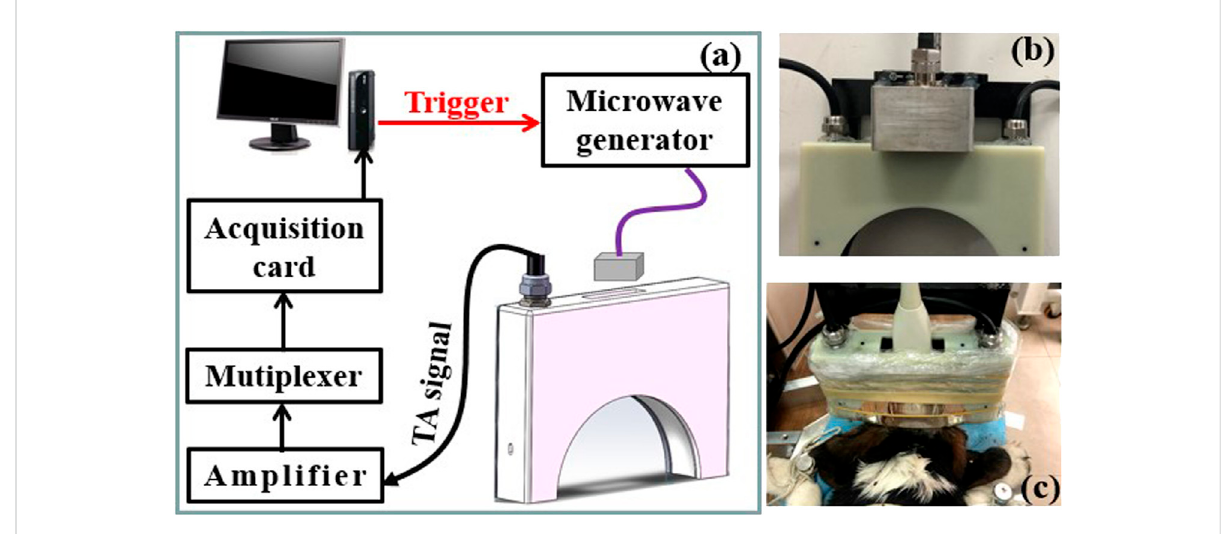
FIGURE 1 (A) Schematicofthethermoacousticimaging(TAI)system. (B,C) Photographoftheantennaandhollowconcavetransducerarray,thedogbrain to be imaged,